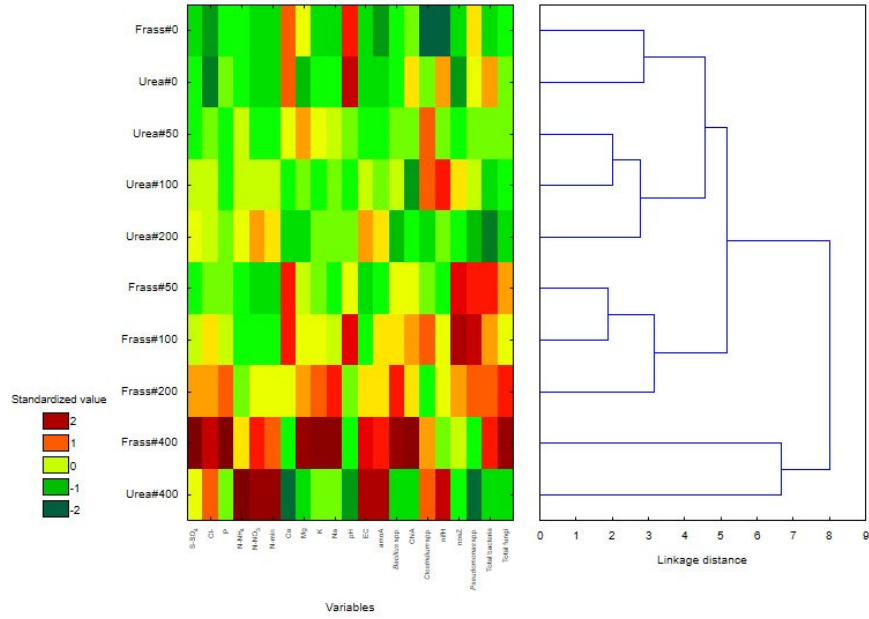
Figure 5. Heatmap with a clustering tree.